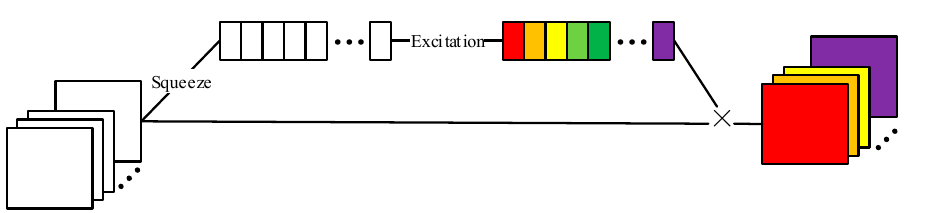
Figure 4. Principle of channel attention mechanism.